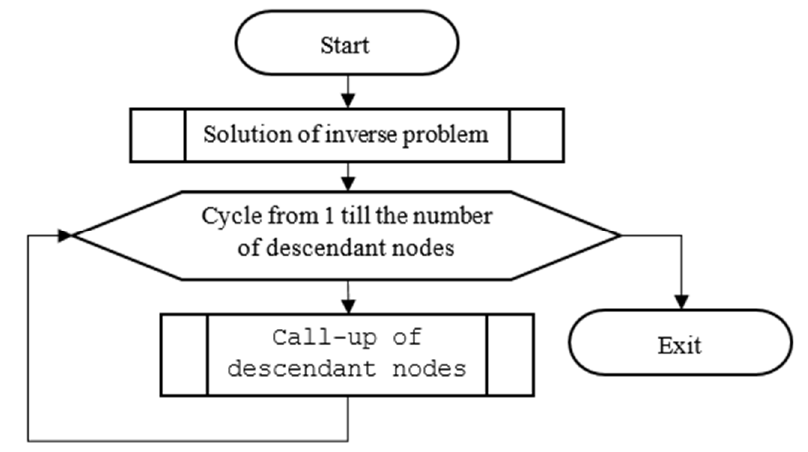
Figure 3. The procedure for traversing the tree: calling up descendant nodes. Figure 4 present the general algorithm for solving the inverse problem. The condition